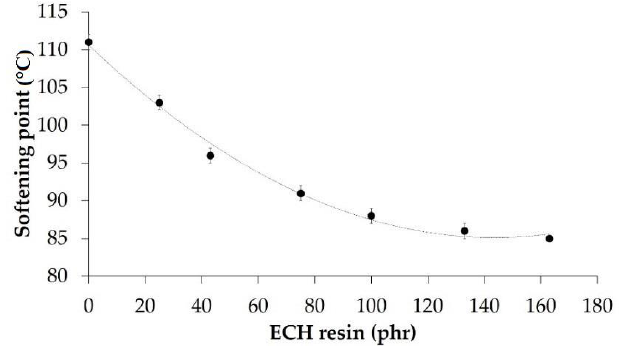
Figure 3. Variation of the softening point of the EBA copolymer + ECH resin blends as a function of their ECH resin content. Softening point of the ECH resin: 103 °C.